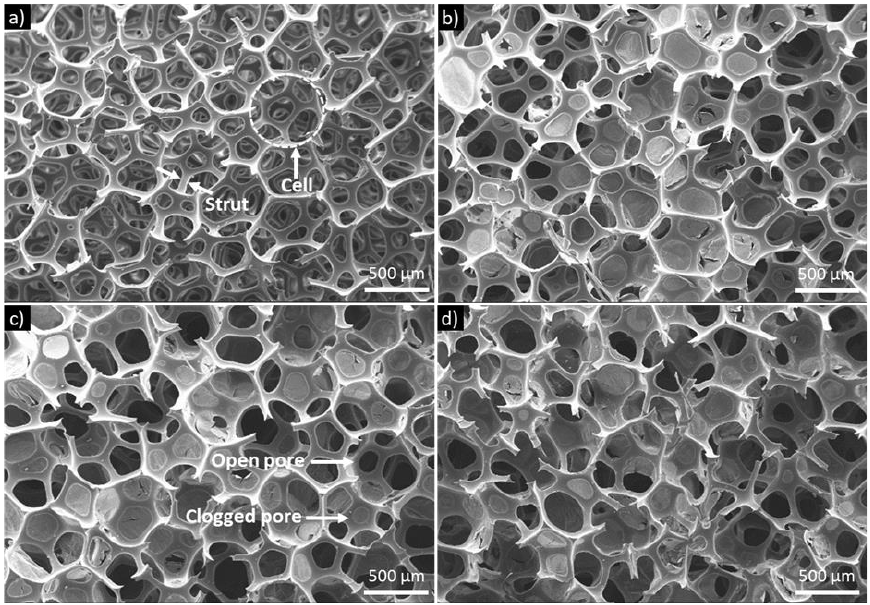
Figure 3. SEM images of the bare structured support ( a ) and of the samples activated by GO washcoat: one deposition ( b ), two depositions, ( c ) and three depositions ( d ).